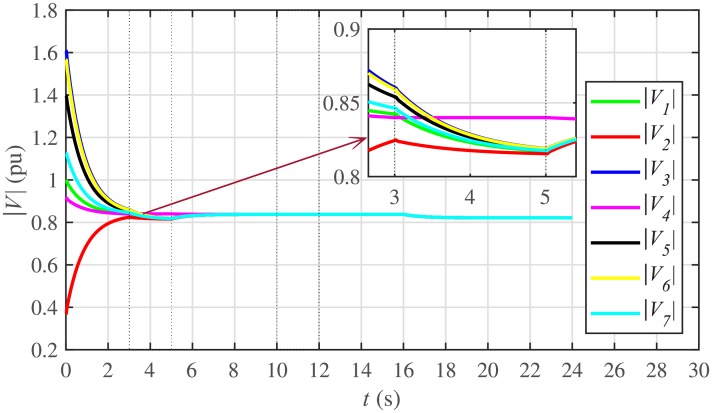
Voltage regulation under case 6. [27].